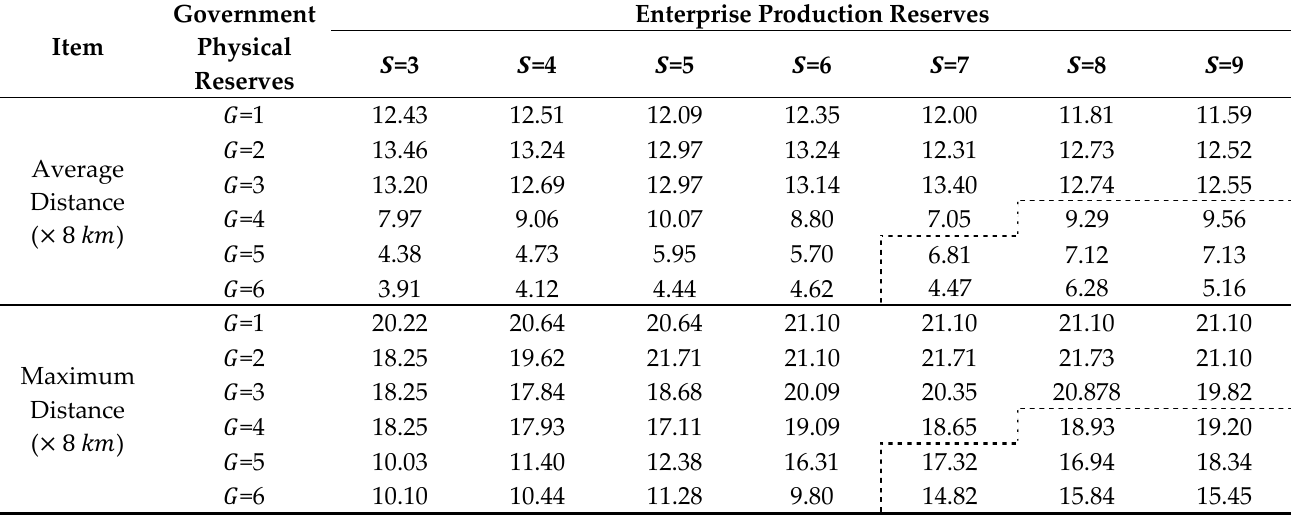
Notes: the location schemes with 100% coverage in the repeated simulations are surrounded by dashed